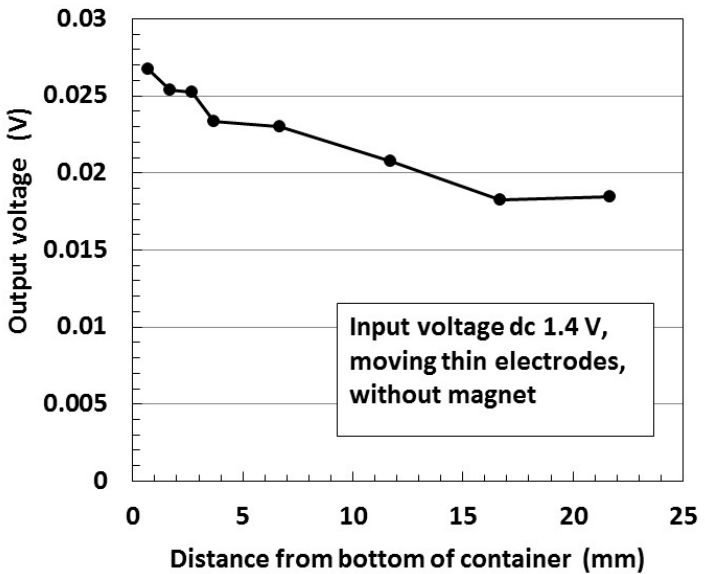
Figure 16. Output voltage and the distance of container for moving electrodes without a magnet and the application of dc 1.4 V of input voltage.